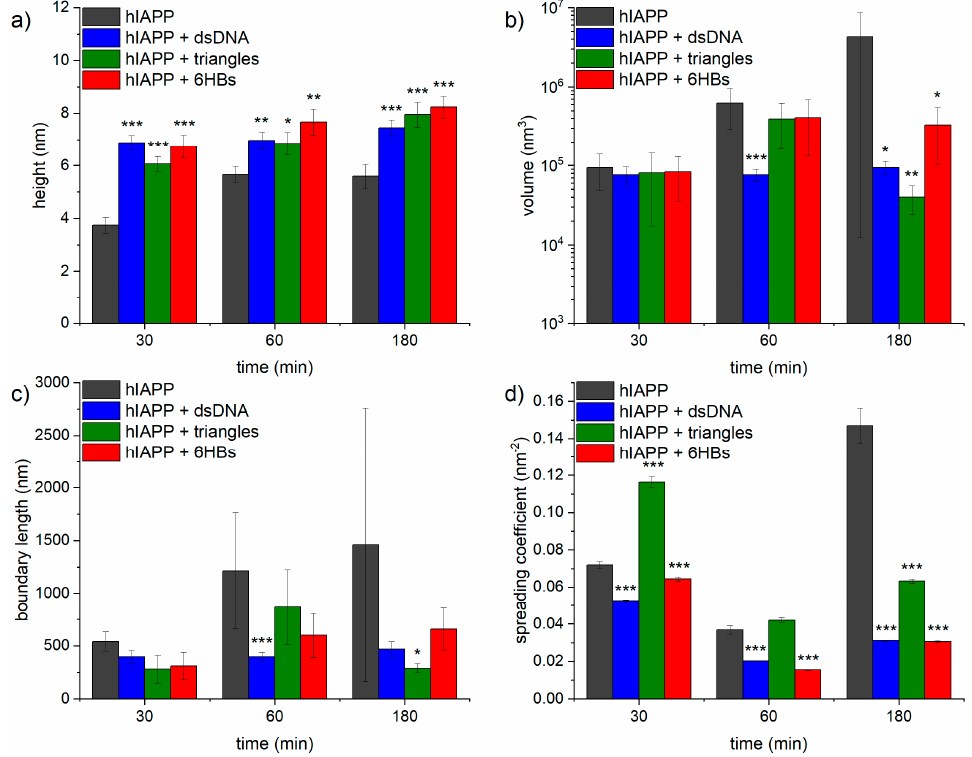
Figure 4. ( a ) Average heights of hIAPP fibrils obtained in the presence and absence of the different DNA structures. Values represent averages of 21 to 30 individual fibrils. ( b ) Average volumes of hIAPP aggregates obtained in the presence and absence of the different DNA structures. Values represent averages of 163 to 5285 individual aggregate structures. Note the logarithmic y -axis. ( c )